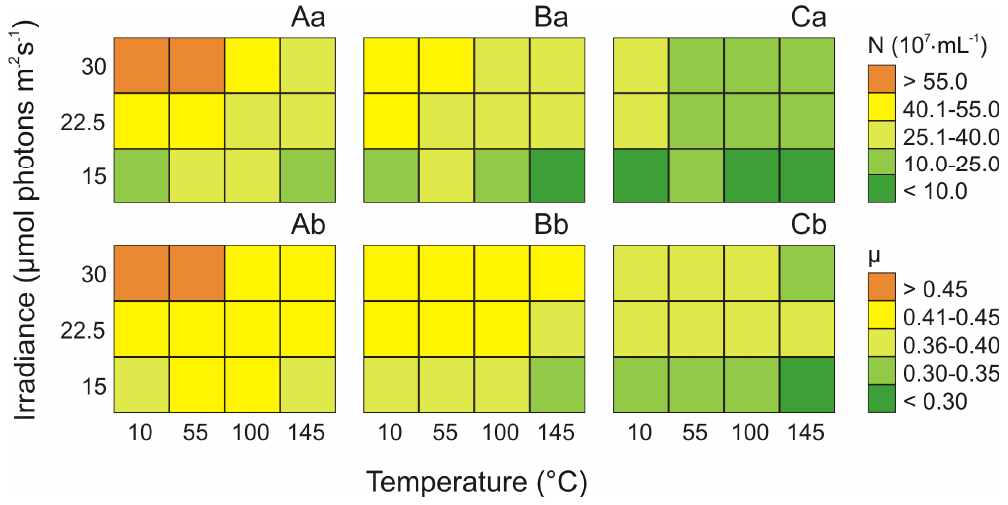
Figure 1. Changes in the number of cells (N × 10 7 mL − 1 ; a ) and the growth rate ( µ ; b ) obtained after 14 days of experiment for three phenotypes of Synechococcus sp.: Type 1 ( A ), Type 2 ( B ), Type 3a ( C ) under different irradiance ( μ mol photons m − 2 s − 1 ) and temperature (°C) conditions.